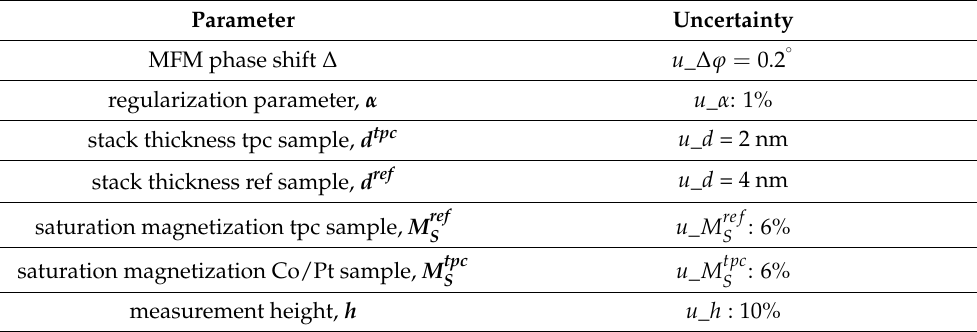
Table A1. Uncertainties used for the calculation of the uncertainty bands. Parameter Uncertainty MFM phase shift ∆ u _ ∆ ϕ = 0.2 ◦ regularization parameter, α u _ α : 1% stack thickness tpc sample, d tpc u _ d = 2 nm stack thickness ref sample, d ref u _ d = 4 nm u _ M ref saturation magnetization tpc sample, M ref : 6% S S saturation magnetization Co/Pt sample, M tpc